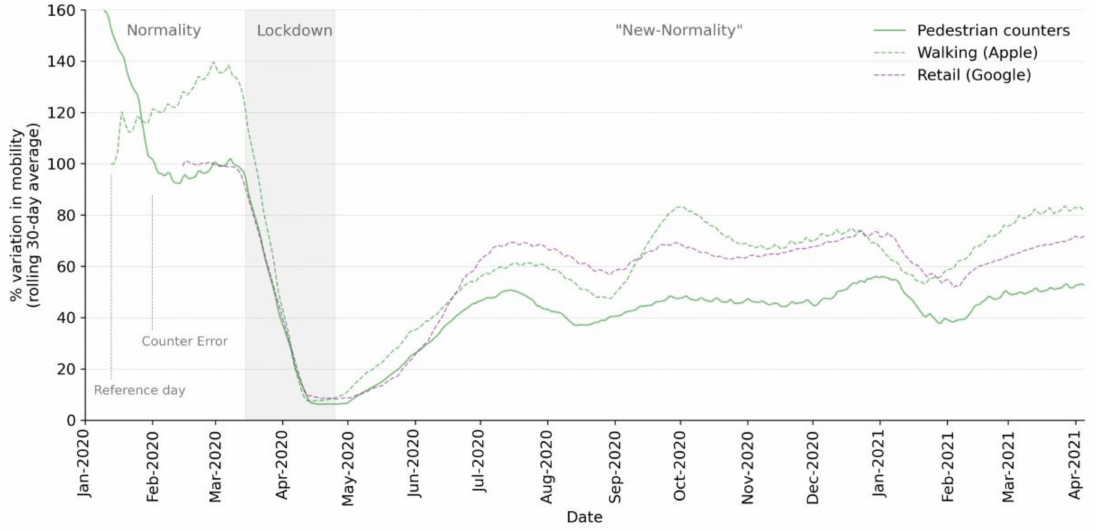
Figure 4. Variation (%) in the number of pedestrians from the reference